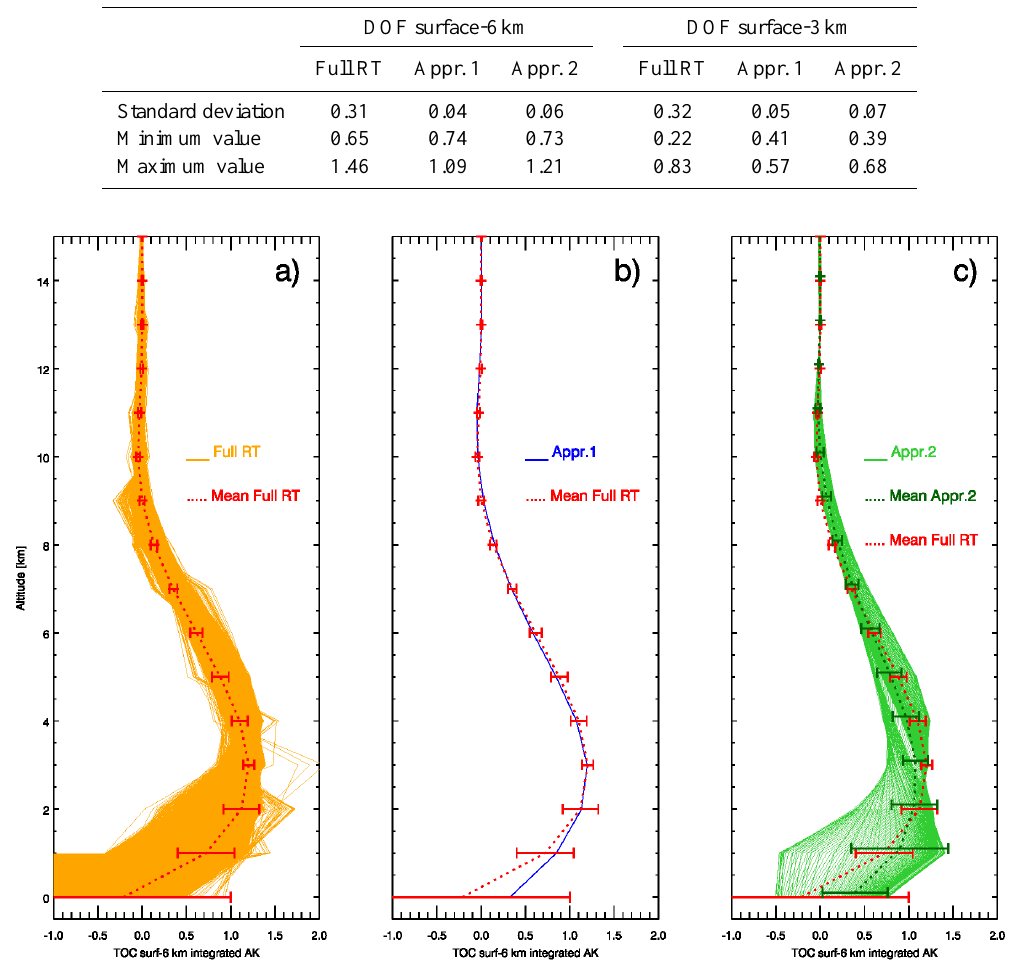
Fig. 1. Full RT ( a , in orange), approximation 1 ( b , in blue) and approximation 2 ( c , in light green) integral averaging kernels for the ozone partial column from surface to 6km, for 20 August 2009 09:00UTC, over Europe. The mean averaging kernel and standard deviation (points and bars) for full RT is also shown (red line), as well as for approximation 2 (green